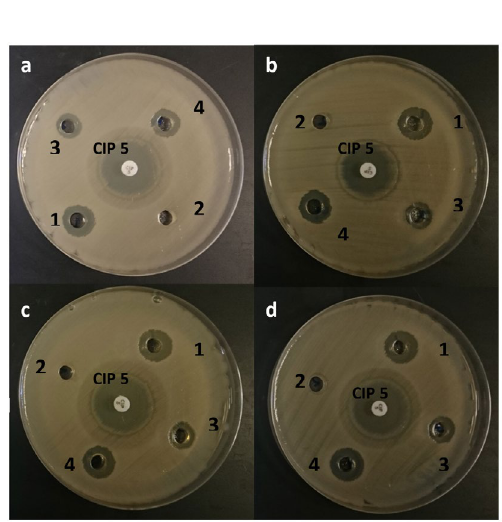
Fig. 3. Antimicrobial activity of the 3 isolates against the test pathogens: In this figure: a: Enterobacter sp., b: P. mirables , c: Staphylococcus sp., d: Streptococcus sp. No. 2 well and CIP 5 (Ciprofloxacin 5 μg/disc) were used as a negative and positive control.